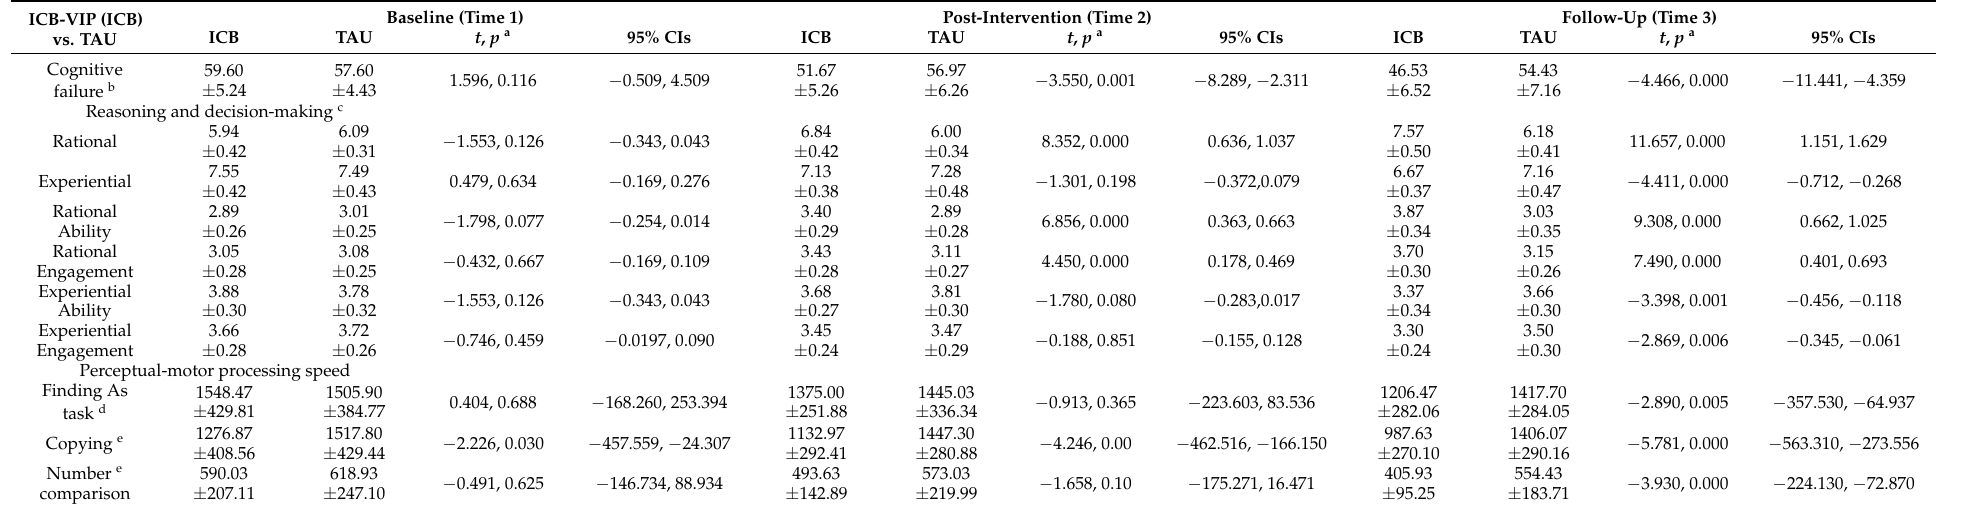
Table 3. Pre-post-intervention and follow-up data for neurocognition, reasoning style and